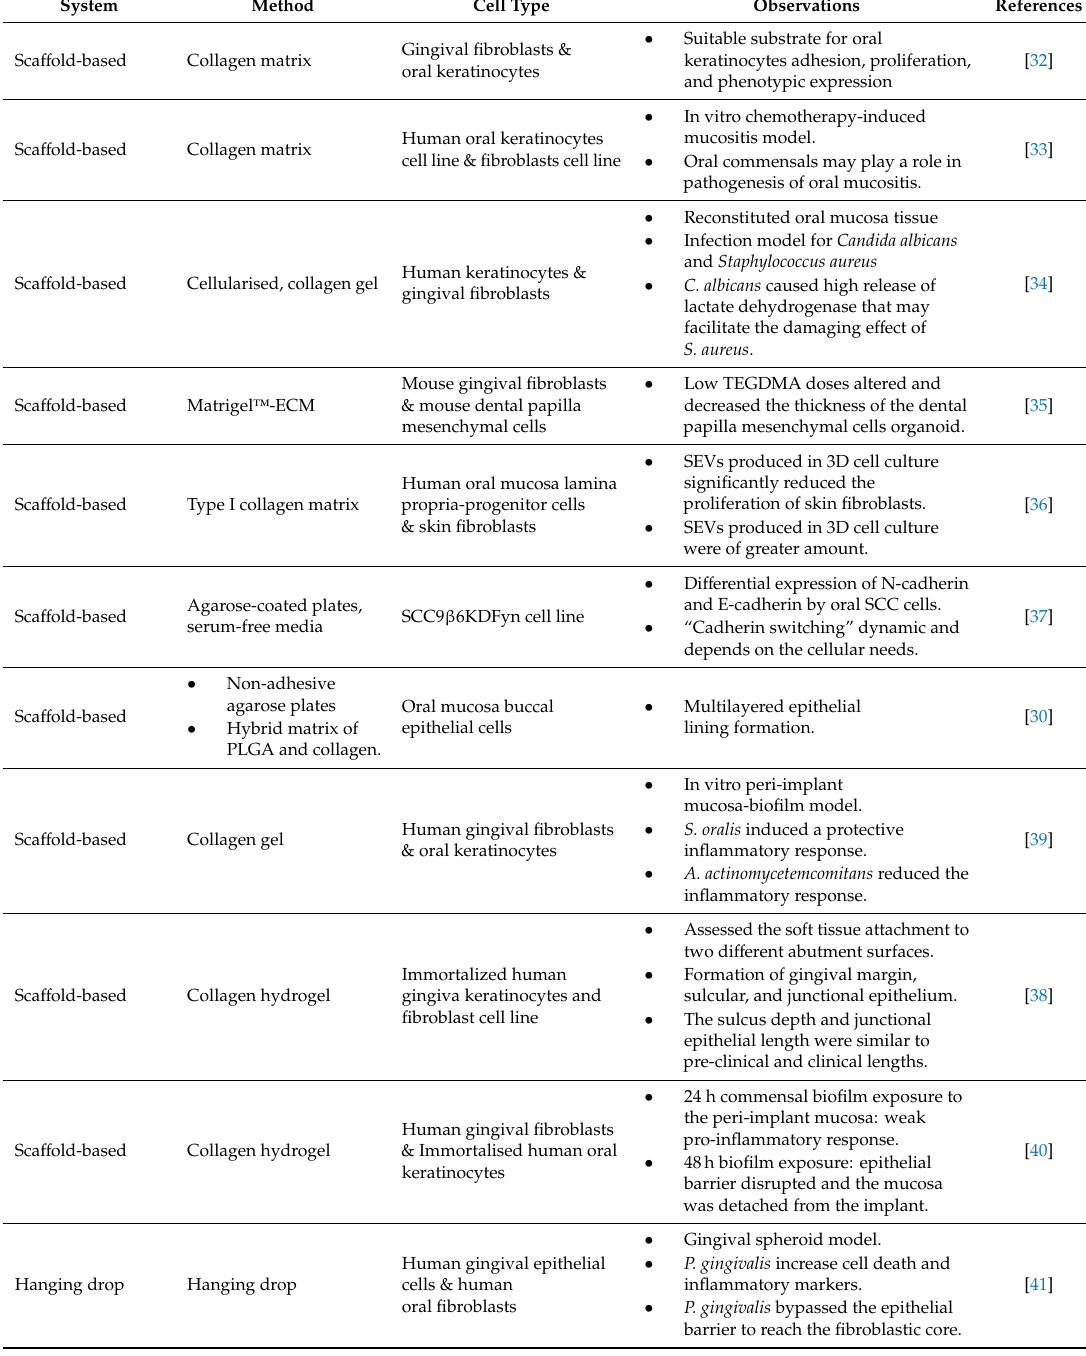
Table 1. Oral mucosa 3D culture